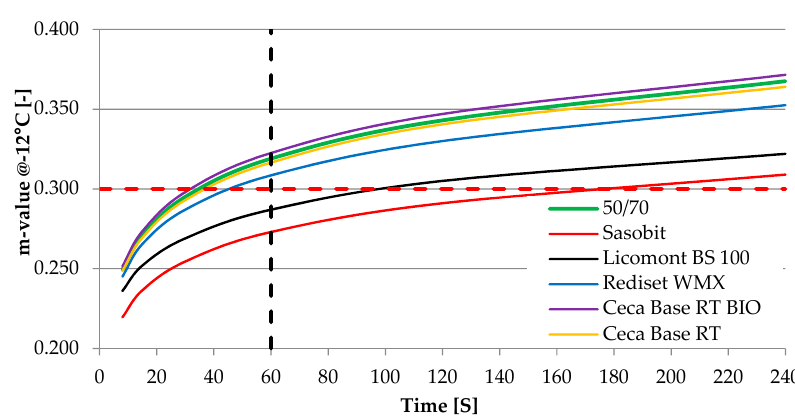
◦ C from the BBR Figure 2. m-value obtained at –12 °C from the BBR test. Figure 2. m-value obtained at –12 Figure 2. m-value obtained at –12 °C from the BBR test.